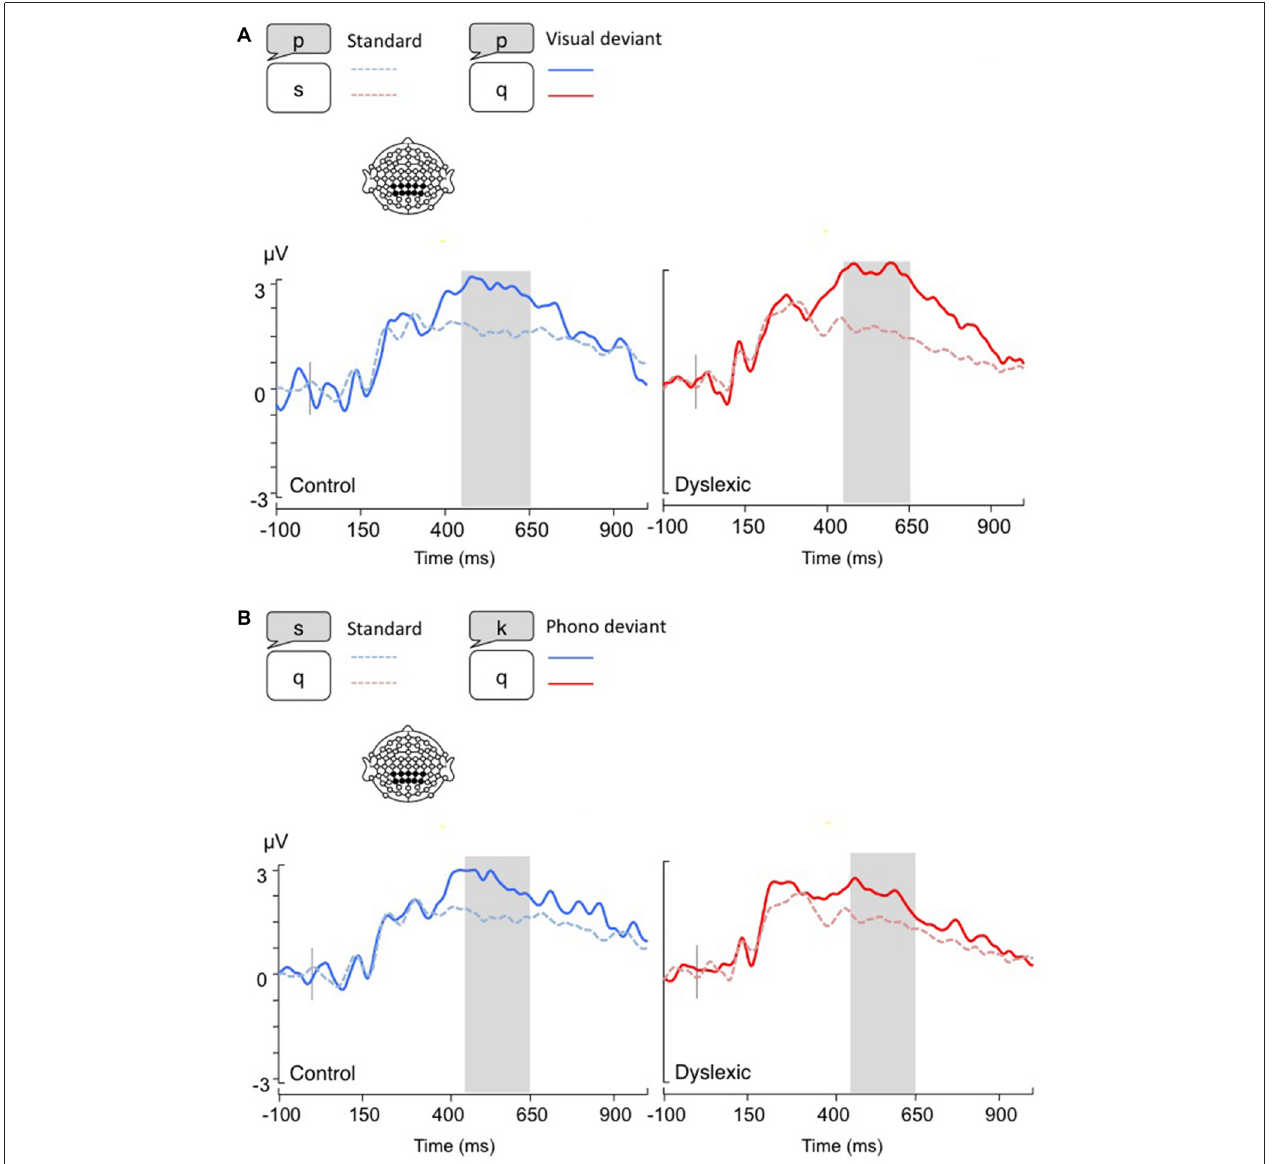
FIGURE 2 | Linear derivations over the electrodes where the P3b was maximal for typical and dyslexic readers’ responses in correct trials (Gray bar: analysis window). (A) Visual-orthographic deviants; (B) Phonological